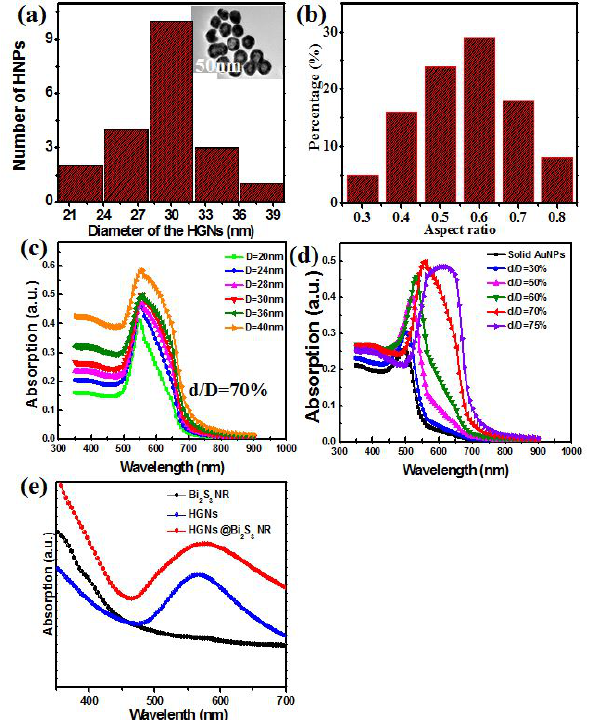
Fig. 4. (a) Statistical distribution of the HGNs diameter. (b) The inner-to-outer radius aspect ratio of the HGNs. (c) Theoretical sim- ulation of the HGNs with different diameters, the diameters are from 20 to 24, 28, 30, 36, and 40 nm. In addition, the inner-to-outer radius aspect ratios of all HGNs are set to be 70%. (d) Theoretical simulation of absorption of HGNs, the HGNs have inner-to-outer radius ratios ranging from 0 to 75%, the diameters of all nanoparti- cles (including both solid AuNPs and HGNs) are set to be 30 nm. (e) Experimental absorption spectra of Bi 2 S 3 NRs, HGNs and HGNs @ Bi 2 S 3